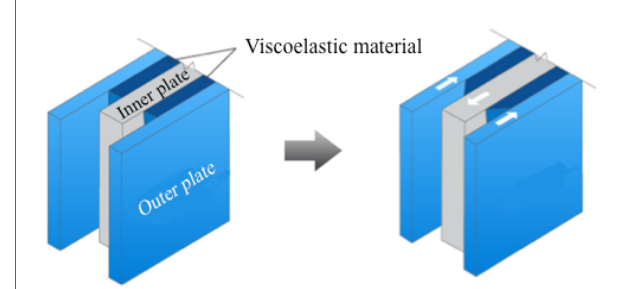
FIGURE 1 | Principle of VED .